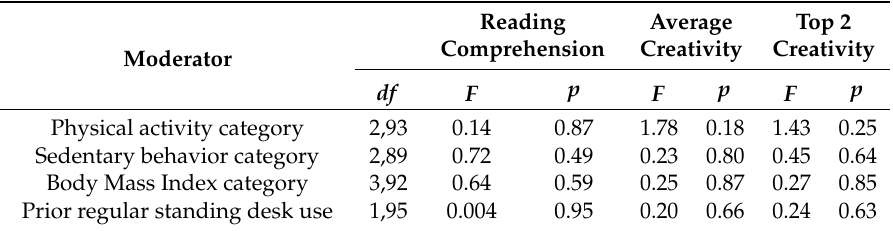
Table 4. Analyses Testing Moderation of Position-Performance